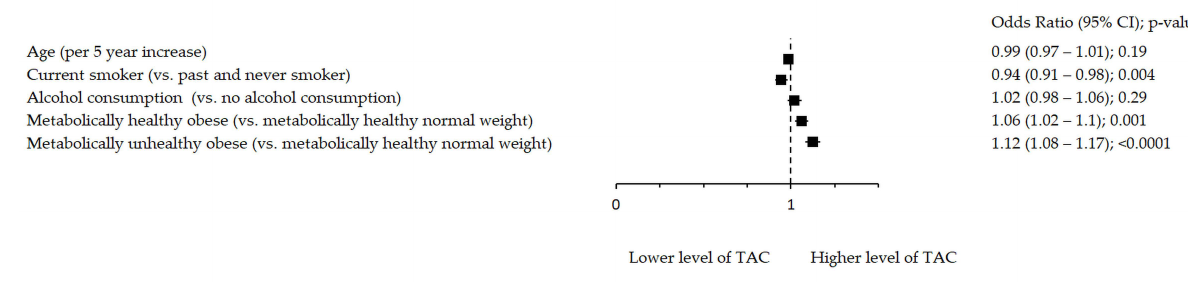
Figure 2. Association between TAC and metabolic health status. The forest plot shows multivariable analyses. The odds ratio with 95% confidence interval (CI) was obtained for precision and adjusted by age, smoking and